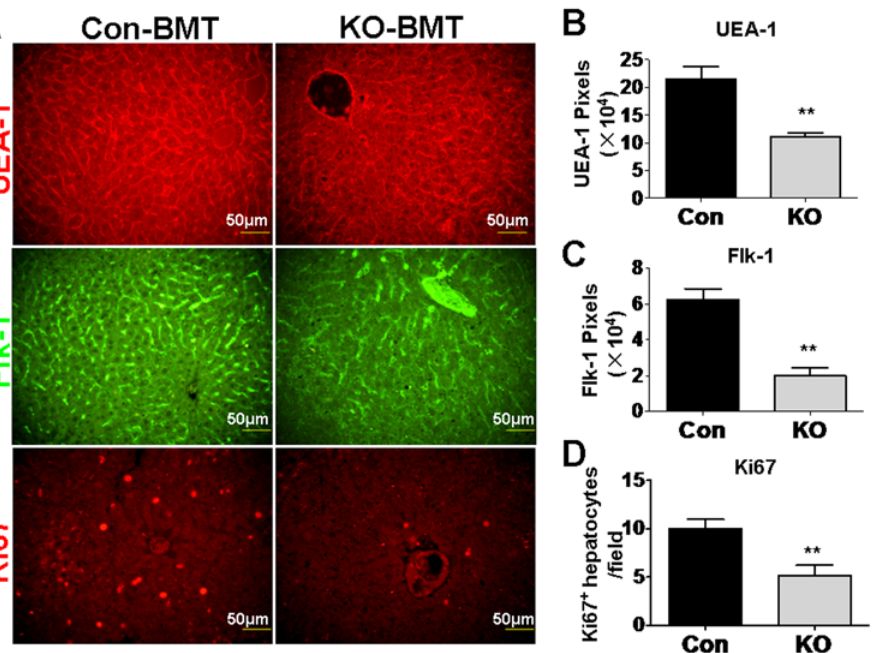
Figure 1. Mice transfused with the RBP-J deficient BM cells showed attenuated SEC and hepatocyte regeneration after PHx. BM cells were isolated from the RBP-J deficient or the control mice, and were transfused into irradiated normal mice. Two months later, the recipient mice were subjected to PHx, and were analyzed 3 days after the operation. ( A ) The immunofluorescent staining of UEA-1 (top), Flk-1 (middle), and Ki67 (bottom) with the liver sections of the recipient mice after PHx. ( B, C ) UEA-1- ( B ) and Flk-1- ( C ) positive signals in the upper and middle panels of ( A ) were quantified by the representative pixels, and were compared between the two groups. ( D ) Ki67 + round nuclei were counted under microscope, and were compared between the two groups. KO, RBP-J gene knockout mice; Con, control mice. Bars=mean 6 SD; n=4; ** P ,